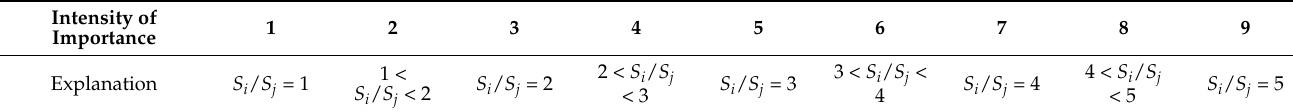
Table 3. Fundamental scale used to develop the priority matrix for